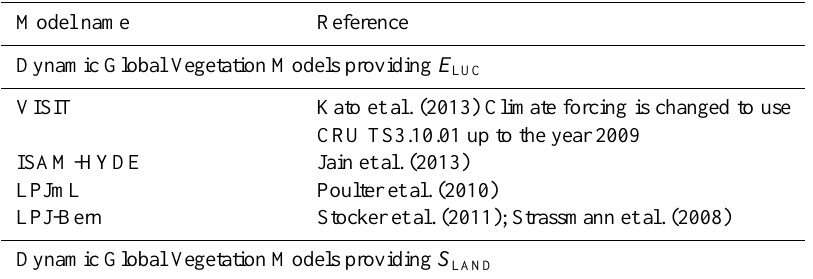
Table 3. References for the process models included in Fig.